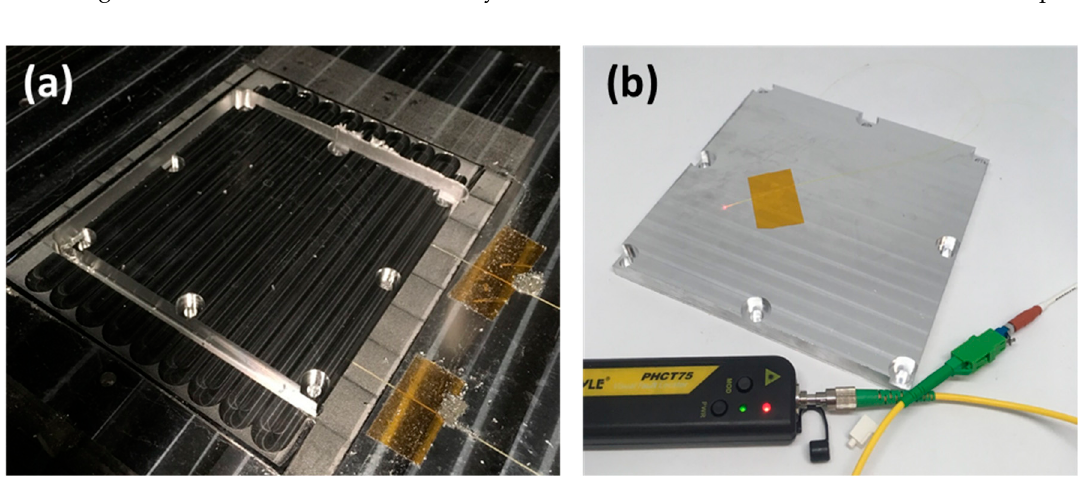
Figure 4. Final part dimensioning and inspection: ( a ) finishing operations on smart baseplate; ( b ) inspection of finished baseplate using red light. Strategic CNC stage cutting operation permitted embedding of fiber without damage and enabled part release from initial stock.